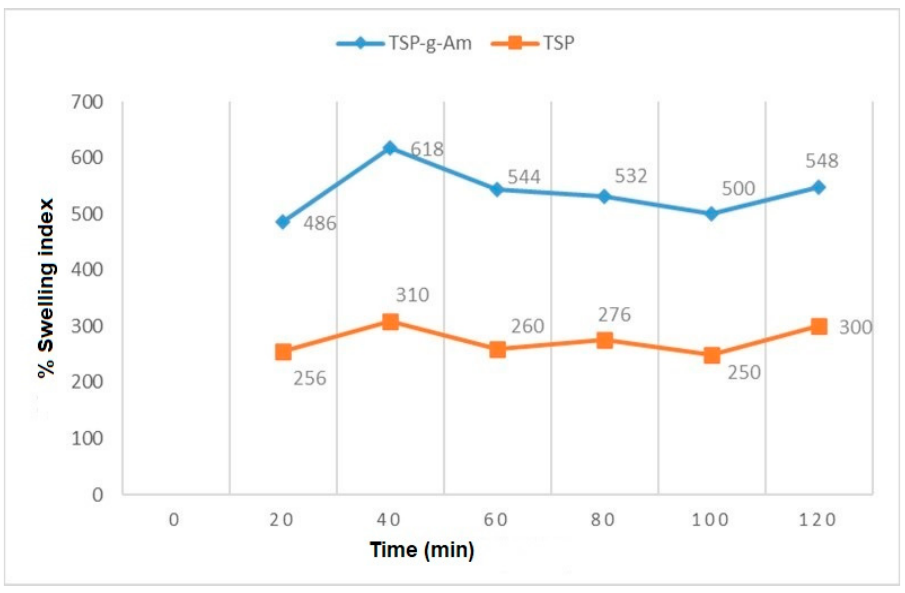
Figure 6. Plot showing swelling and deswelling studies on the grafted polymer.